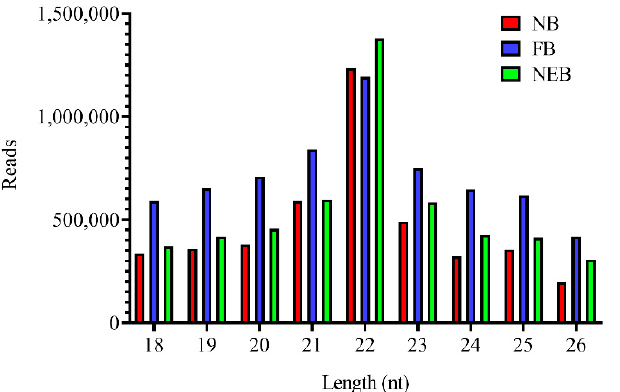
Figure 1. Distribution of the lengths of the small RNA reads in the nurse bee (NB), forager bee (FB), and newly-emerged bee (NEB) libraries.